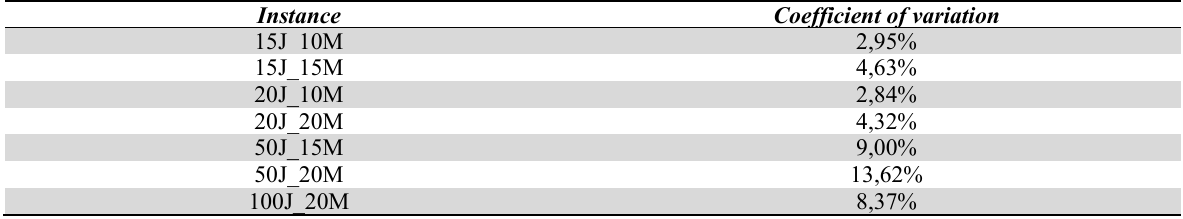
Hypervolume average coefficient of variation for each instance Instance Coefficient of